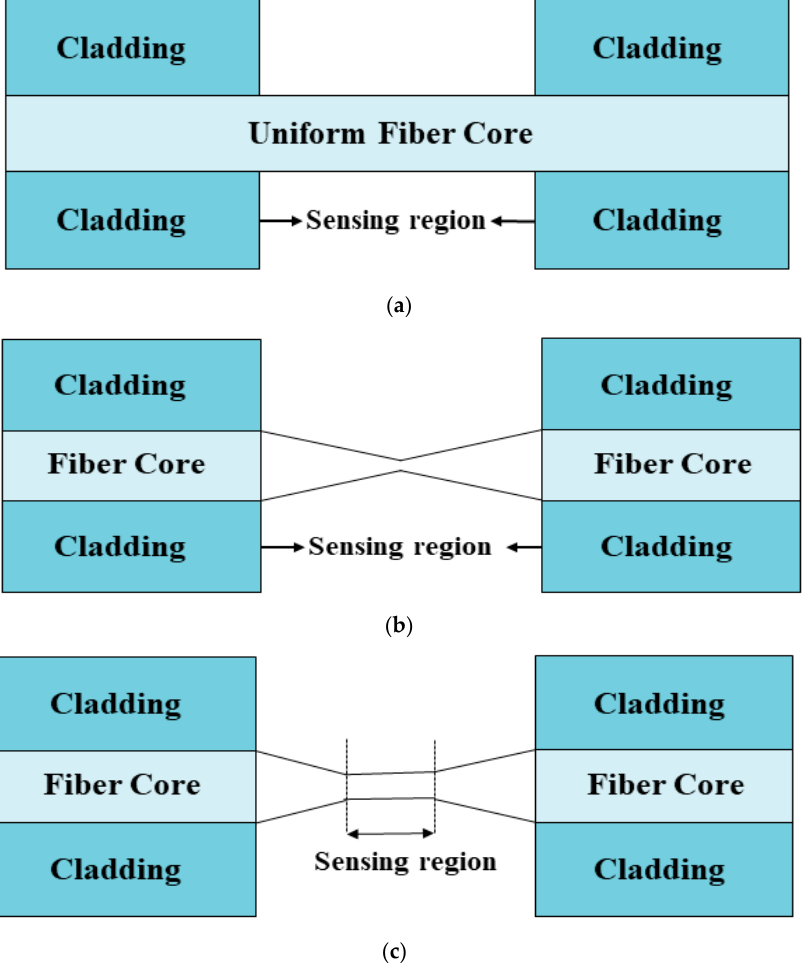
Figure 2. Schematic view of LMR-based ( a ) uniform-core fiber optic probe, ( b ) tapered-core fiber optic probe, and ( c ) uniform-core tapered fiber optic probe.